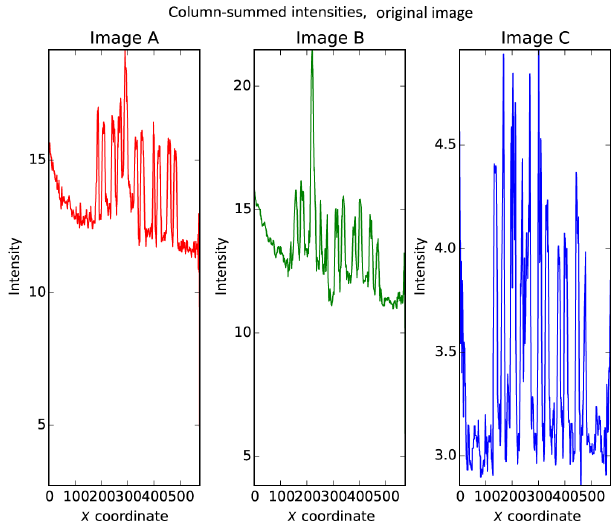
Figure 7. The column-summed intensities of the clock display in- tensities of images A, B and C (Figs. 4, 5 and